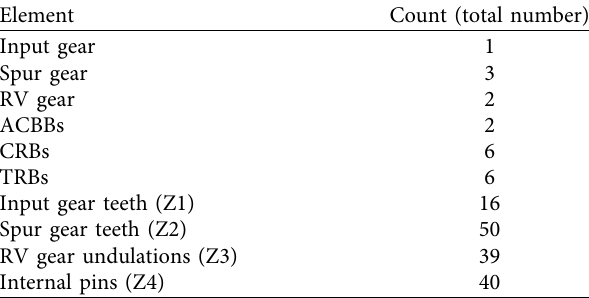
Figure 1: Nabtesco’s RVN mechanism block [27]. Table 1: Nabtesco RV-42N